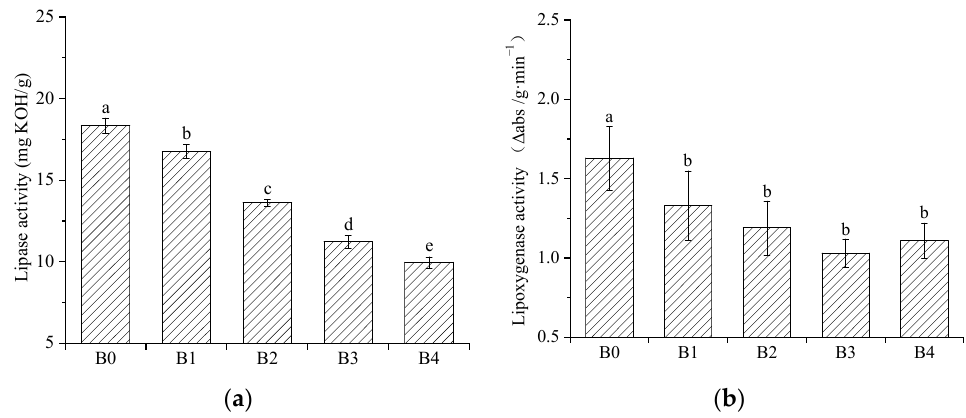
Figure 6. Lipase activity ( a ) and lipoxygenase activity ( b ) of wheat bran. The B0, B1, B2, B3, and B4 are the wheat bran prepared under the rolling frequency 0, 6, 9, 12, and 15 times. Different lowercase letters on the shoulders of the column indicate significant differences ( p < 0.05).